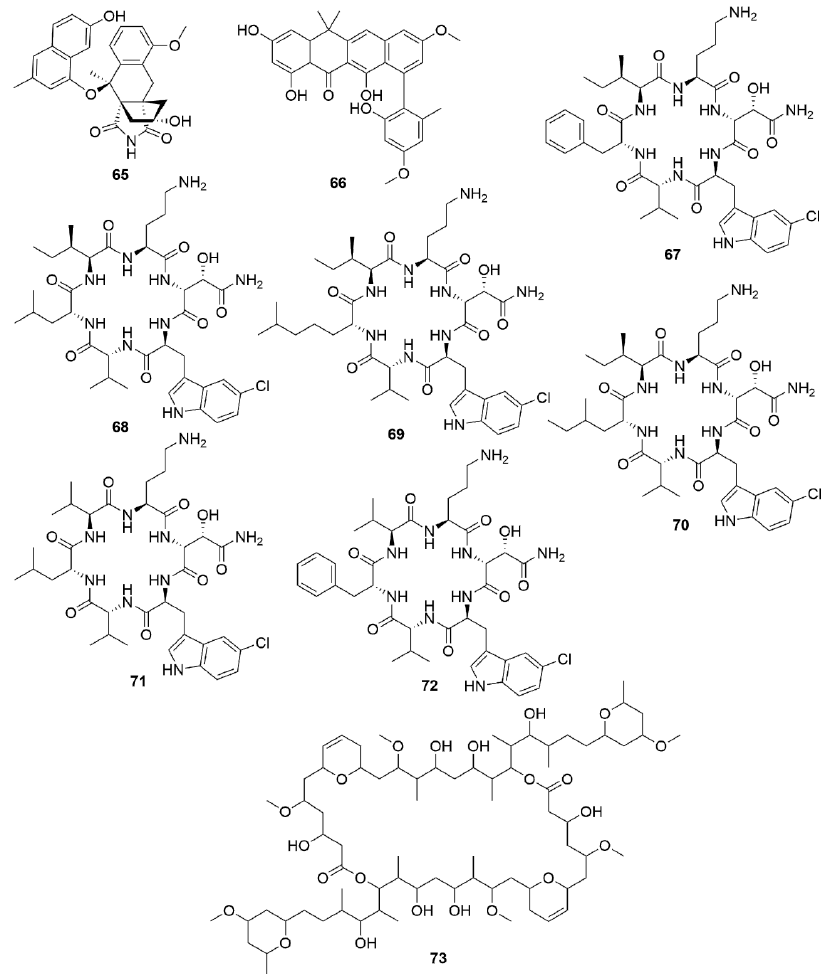
Figure 7. Examples of recently isolated bacterial natural products employing the GNPS and SMART technologies. Lugdunomycin ( 65 ), a novel angucycline-derived polycyclic aromatic polyketide with antimicrobial properties, isolated from Streptomyces sp. QL37 utilising a metabolomic